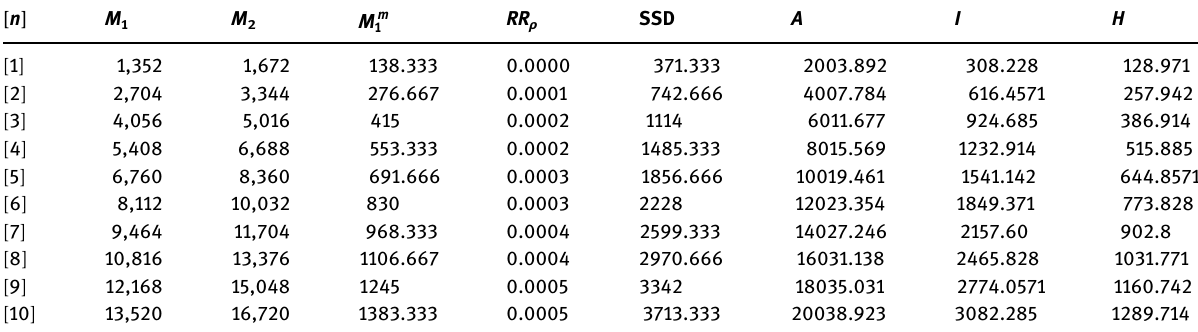
Table 6: Comparison of topological invariants by applying M - polynomial for cuboctahedral bimetallic networks ( MOPs ) at x = 1 and y = 1